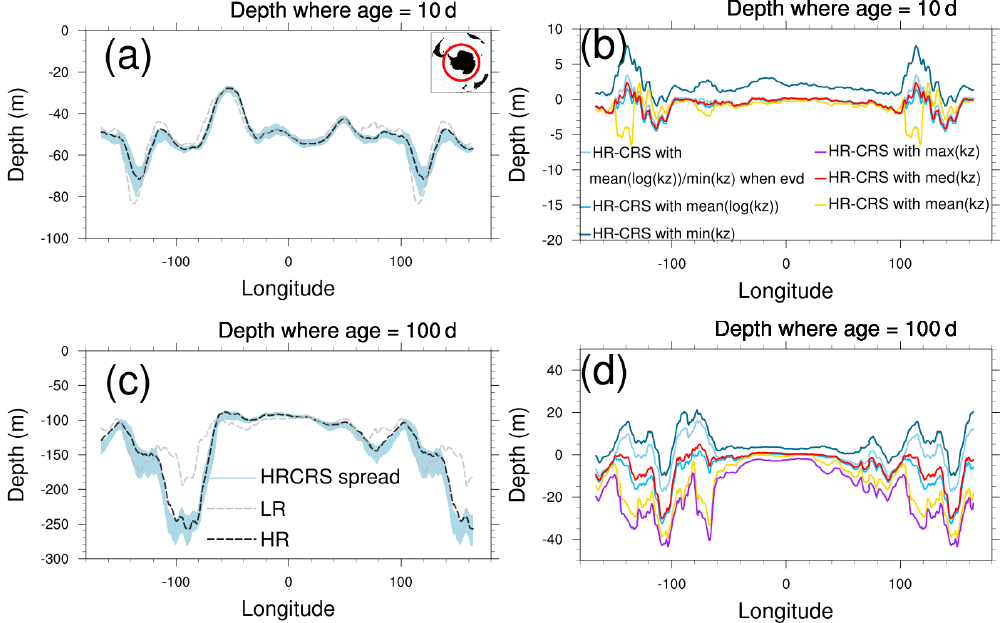
Figure 9. Antarctic Circumpolar Current (ACC) section ( − 58 . 3 ◦ S) of depth where age tracer value is equal to a given age: 10d (a, b) and 100d (c, d) . Panels (a) and (c) compare HR, LR and the mean of HRCRS runs. Panels (b) and (d) show the difference between HR and all the HRCRS